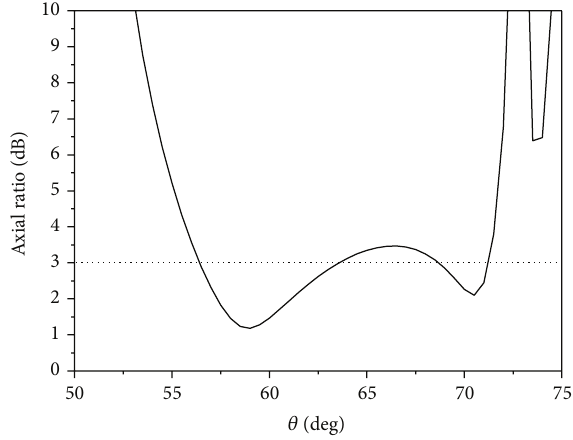
Figure 13: Axial ratio of the antenna fed from right